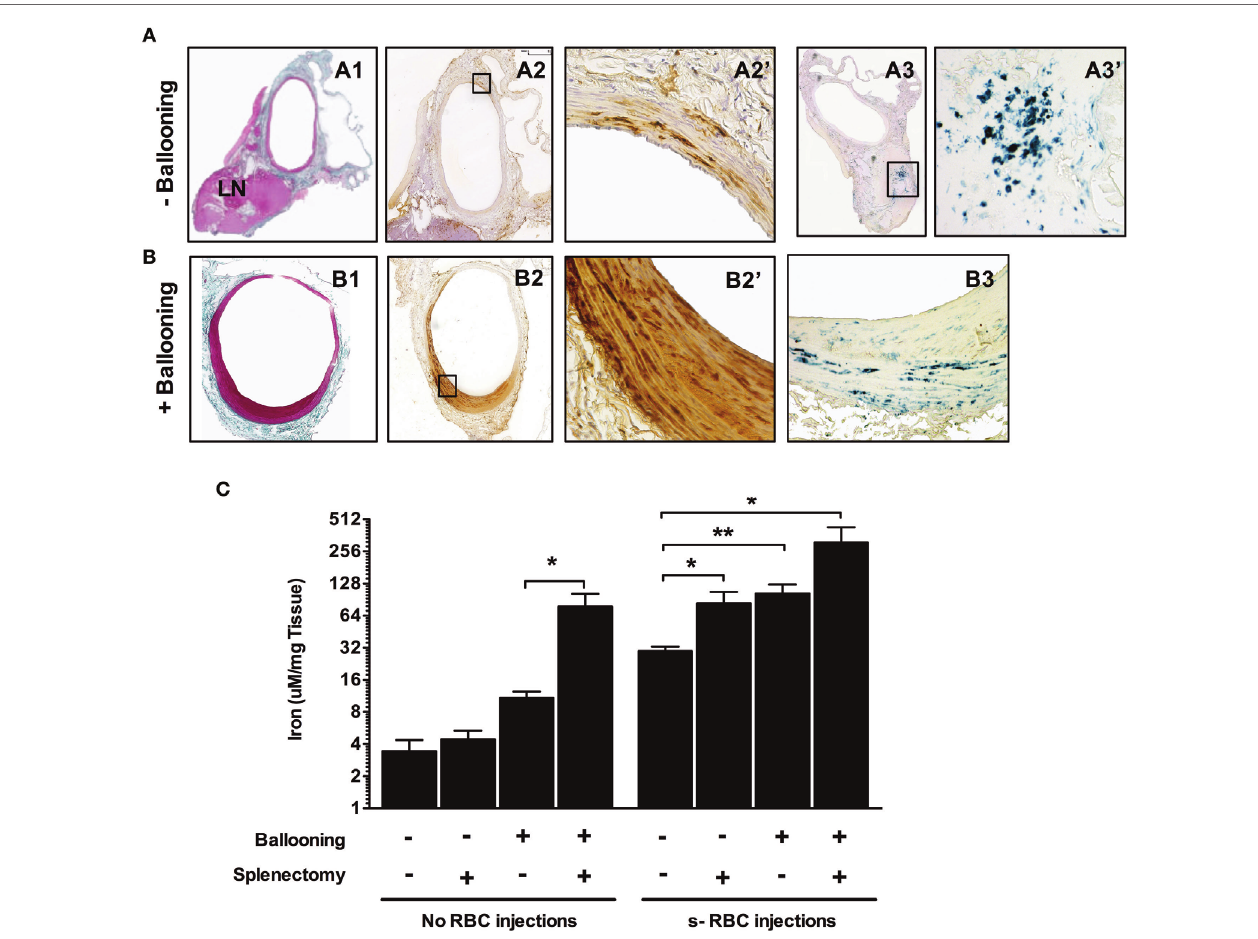
FigUre 9 | Balloon injury promotes red blood cell phagocytosis. Rats were either subjected to intravenous injections of senescent RBCs once a week for 2 weeks or were not. Subsequently, a subset of the rats was submitted to ballooning of the abdominal aorta. [line (a) ] Aorta from a rat injected with senescent RBCs without ballooning. Masson’s trichrome staining (A1) of the aorta associated with an adjacent lymph node. Areas positive for Perls + DiAminoBenzidin (DAB) stainig (A2, A2 ′ ) were observed throughout the media, indicating the presence of redox-active iron (negative for Perls or DAB alone, not shown). Perls staining (A3, A3 ′ ) revealed a continuum of iron transport and metabolism between the arterial wall and the local LN. (B) Aorta of a rat injected with senescent RBCs after ballooning. Masson’s trichrome staining (B1) showing intimal proliferation. Perls + DAB staining (B2, B2 ′ ) indicating the presence of redox-active iron in the intima and media. Perls alone staining (B3), showing an accumulation of ferric iron (sequestered form potentially linked to ferritin) in the arterial wall. (c) Concentrations (logarithmic scale) of iron in the aortas of different groups of rats following senescent RBC injections, ballooning and/or splenectomy ( n = 10 for each group), as determined by spectrophotometry. * p < 0.05 and ** p < 0.01; Mann–Whitney’s